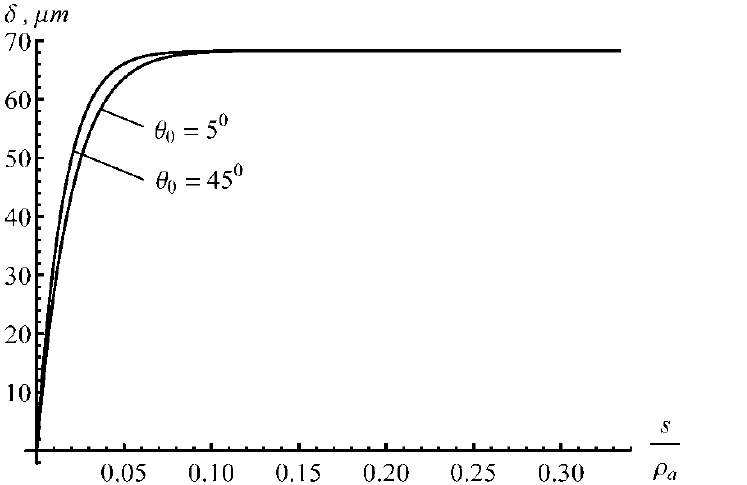
Figure 4. Thickness of the layer of intensive plastic deformation along the friction surface for the Figure 3. Variation of A with the die angle in the range 2 von Mises yield criterion.